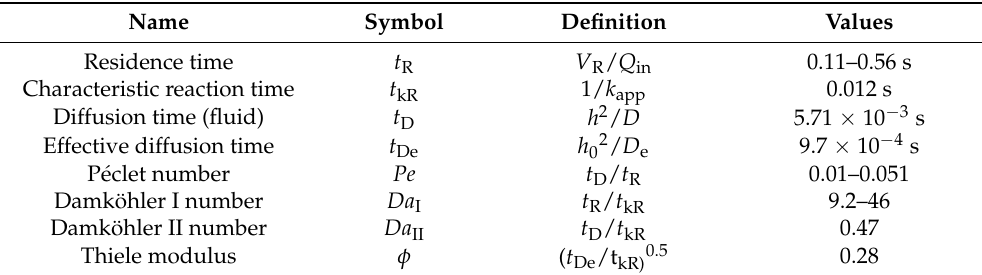
Table 1. Definitions and values of characteristic time scales and dimensionless numbers for the microreactor proposed by Maleki et al. [19].